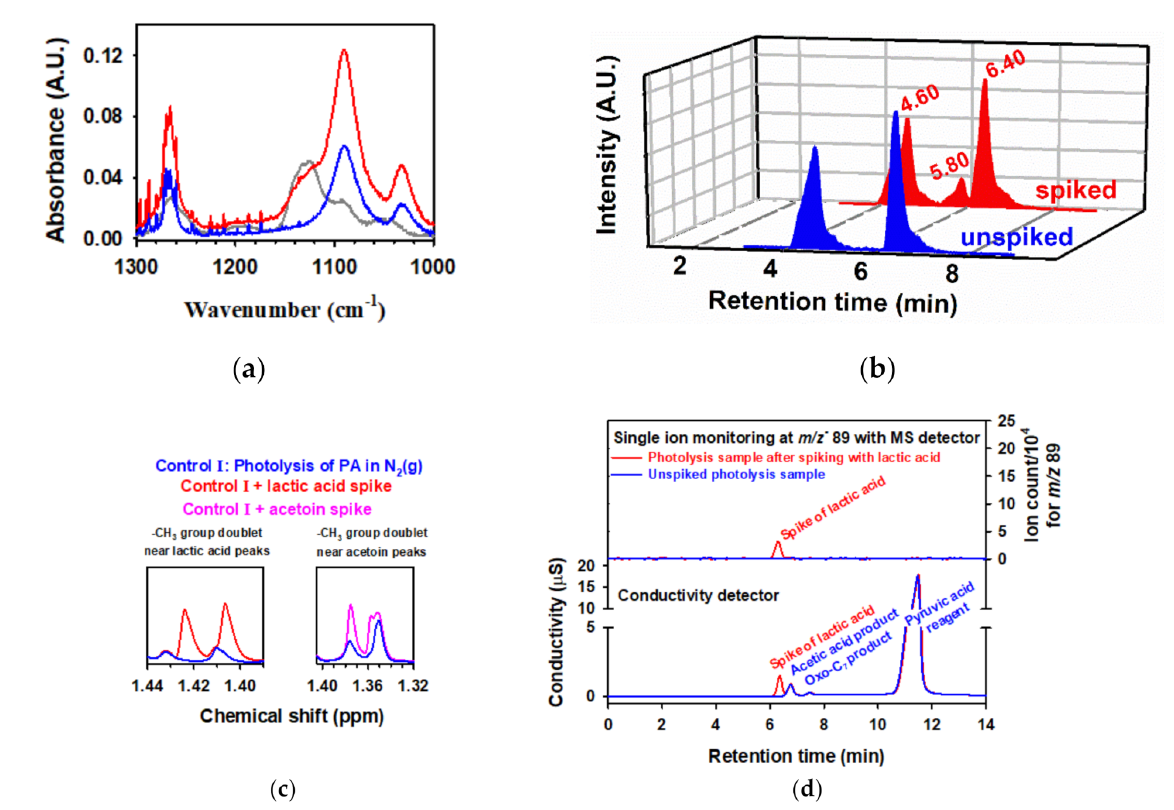
Figure 5. ( a ) Infrared spectrum of (blue line) gas products collected over 50 mM aqueous PA after photolysis ( λ > 305 nm) for 1 h, (gray line) acetoin standard, and (red line) gas product spiked with acetoin clearly demonstrating the absence of this molecule in the headspace of the reactor [83]; ( b ) extracted ion ( m/z − = 267) chromatogram obtained by ultrahigh-pressure liquid chromatography/electrospray ionization( − )/MS (blue line) before and (red) after spiking the photolyzed PA sample for a final concentration of 20 µ M acetoin prior to derivatization to form hydrazones. Retention times for the two hydrazones of PA are 4.60 and 6.40 min, and for the hydrazone of acetoin is 5.80 min (only observable in the spiked sample) but absent in the unspiked chromatogram [83]. ( c ) To the left hand-side is the 1 H NMR spectrum for (blue), the − CH 3 group doublet centered at ∼ 1.42 ppm in a control with 100.1 mM PA at pH 1.0 photolyzed at λ ≥ 305 nm for a 50% reagent conversion under continuous sparging with N 2 (g), and (red) the mismatch for this doublet after spiking to final concentration of lactic acid of 9.34 mM. To the right hand-side is the 1 H NMR spectrum for (blue), the − CH 3 group doublet centered at ∼ 1.36 ppm in the same control in left hand-side, and (pink) the mismatch for this doublet after spiking to an acetoin final concentration of 10.02 mM. This quality assurance analysis clearly demonstrated that lactic acid and acetoin are not photoproducts when working with well purified PA [77]. ( d ) At the bottom, the ion chromatogram is shown with conductivity detection for the region of elution of lactic acid for a control with 99.22 mM pyruvic acid at pH 1.0 photolyzed at λ ≥ 305 nm for a 21% reagent conversion under continuous sparging with N 2 (g) (blue) before and (red) after spiking to a final lactic acid concentration of 14.9 µ M. The anions of all species were assigned with available standards and/or using the m/z −